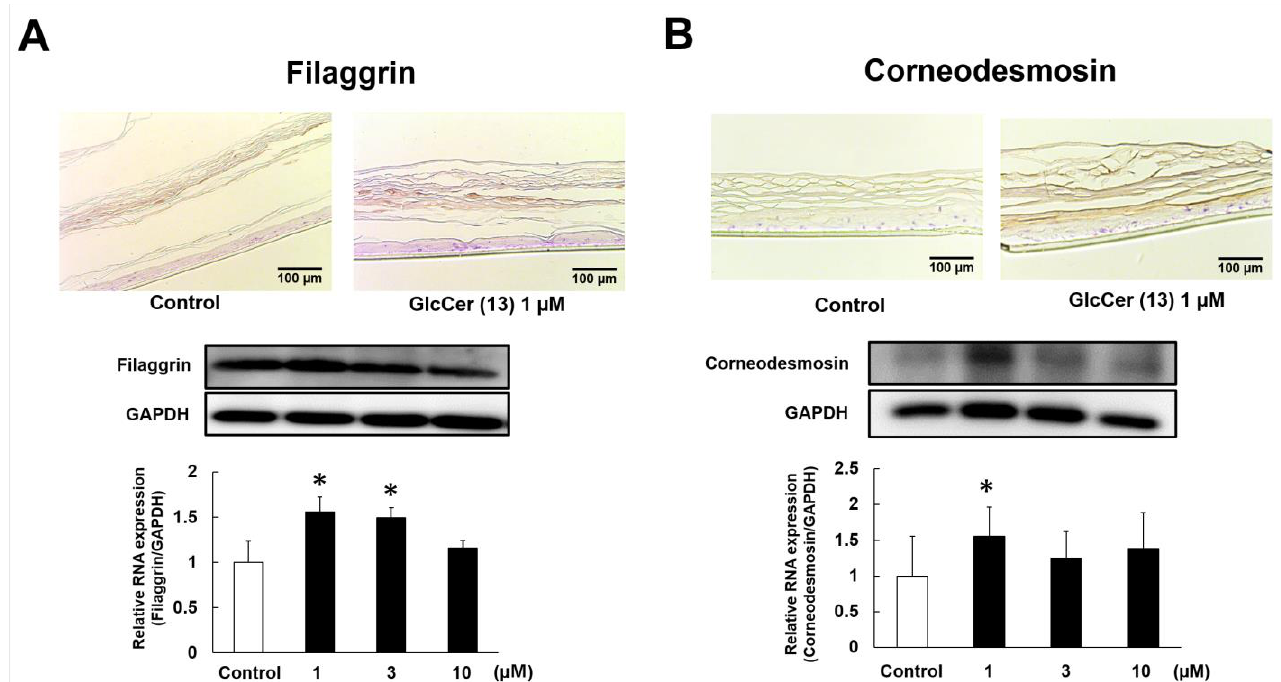
Figure 8. Effects of GlcCer[d18:2(4 E ,8 Z )/26:0)] ( 13 ) on the protein expression of filaggrin ( A ) and corneodesmosin ( B ). The RHEK model was treated for 7 days with 13 . Immunostaining and Western blotting were performed as described in the Materials and Methods section. Data are expressed as means ± S.E. (n = 4 – 5). Asterisks denote a significant difference from the control group, * p < 0.05.